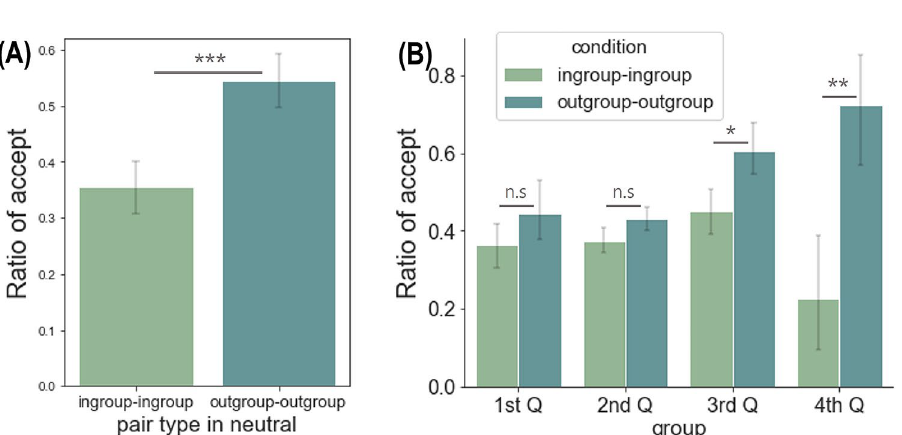
Figure 5. Correlations of the behavioral parameters with each other and RT. ( A ) The individual ingroup bias parameters were negatively correlated with the inequality aversion parameters. ( B ) Individuals with higher ingroup bias parameters showed faster RTs in the ingroup advantageous condition, ( C ) but slower RTs in the neutral condition. All the results are based on two-tailed Pearson correlation analyses and the line shadow indicates the 95% confidence interval.